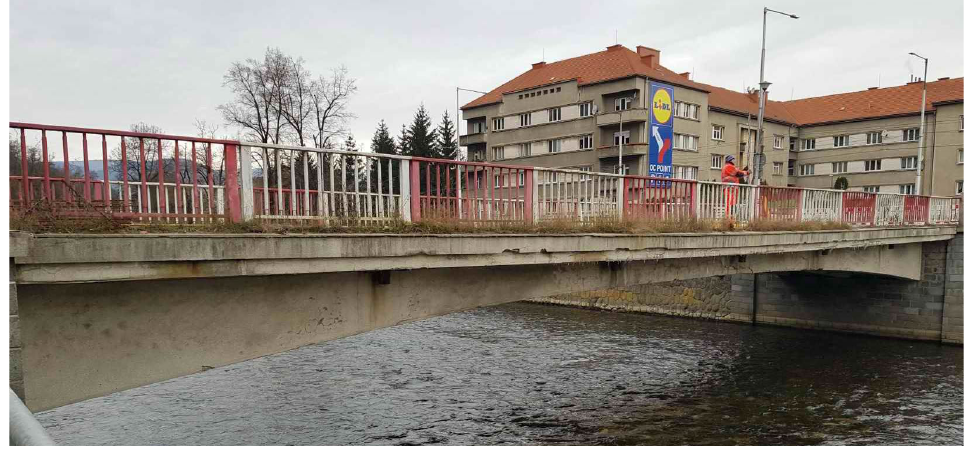
Figure 3. View of the bridge.